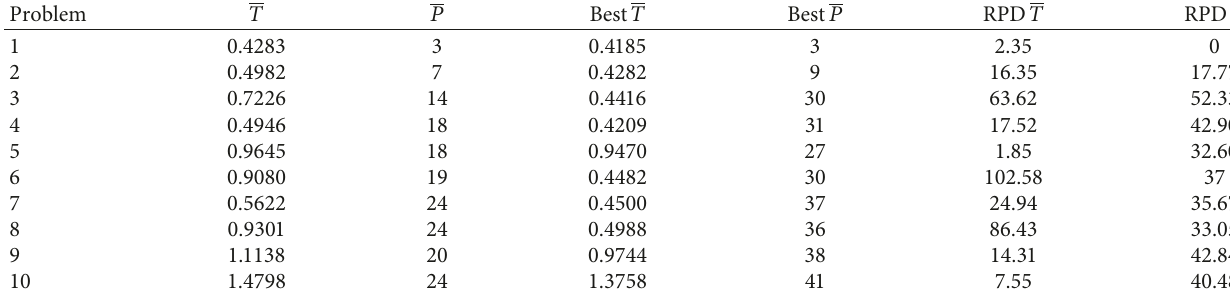
Table 8: Values of RPD criteria for NSGA-II.